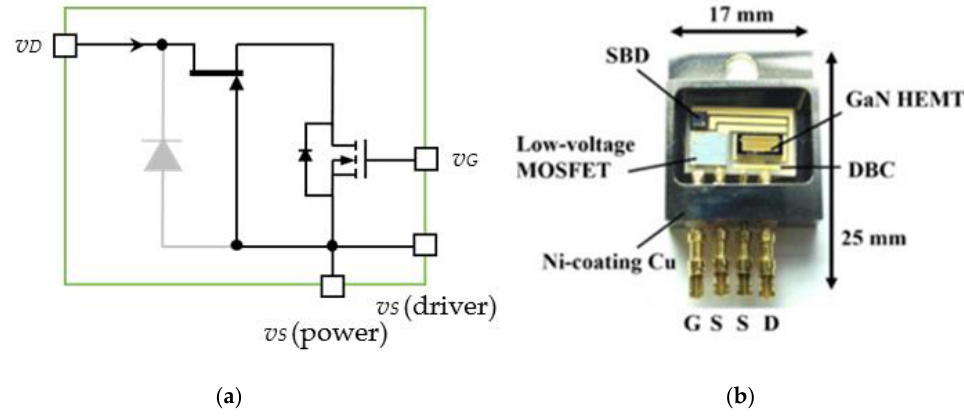
Figure 6. Cascode GaN HEMT: ( a ) the cascode circuit; ( b ) the packaged device.